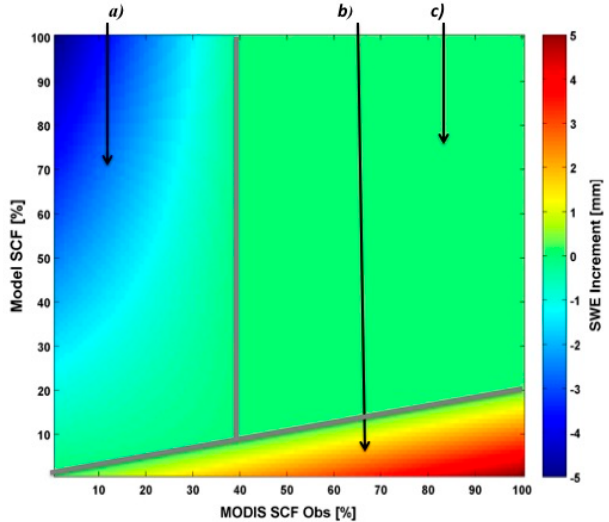
Figure 2. Graphical representation of the empirical formulation used to compute the SWE increment during assimilation of daily MODIS SCF for incr Max = 5 kg m − 2 , SWE_min = 26 kg m − 2 , α = 0.2 [ − ], and β = 40%. Blue ( a ) corresponds to snow removal, red and yellow ( b ) represent the addition of snow and, green ( c ) corresponds to when there is no significant difference between the model and the observations.